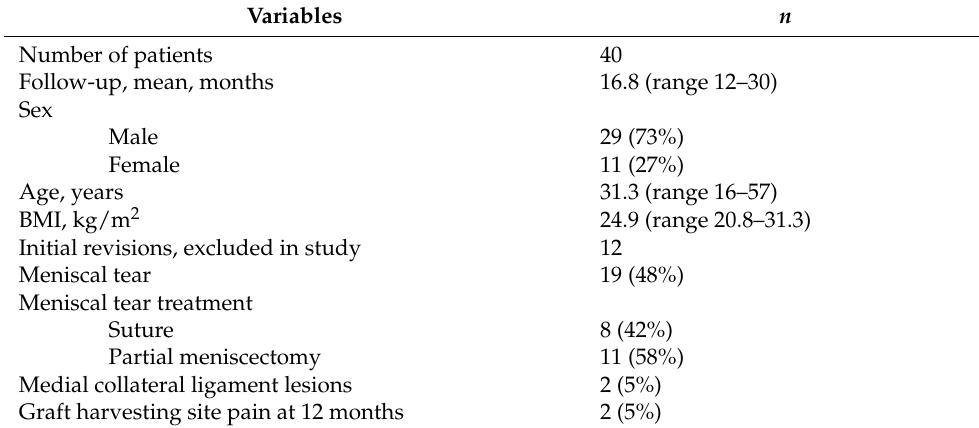
Table 2. Patient demographics. Variables